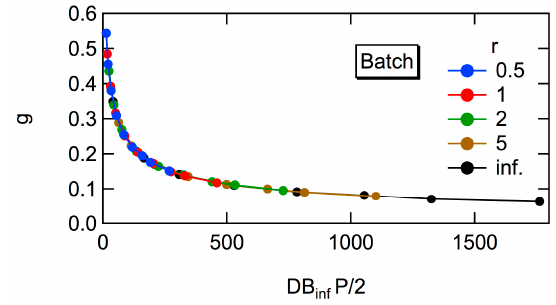
Figure 13. Universal relationship between g and the average number of branch points in a polymer, DB inf P / 2 for batch polymerization.